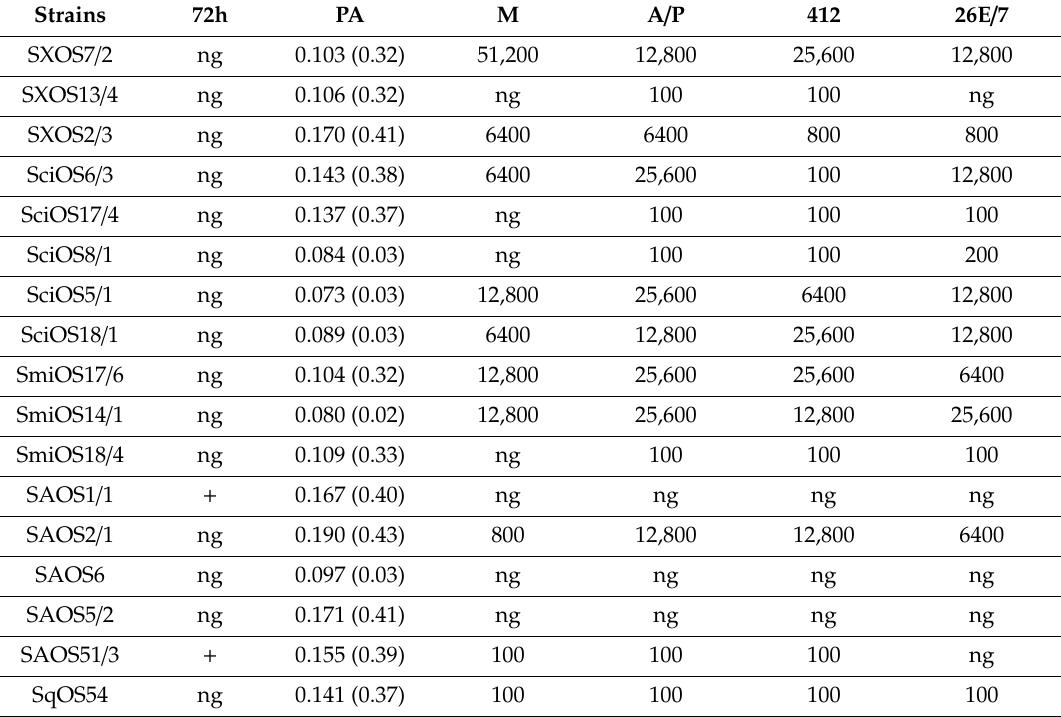
Table 3. Biofilm formation (72 h on Congo red agar, plate assay (PA)) and susceptibility to enterocins.